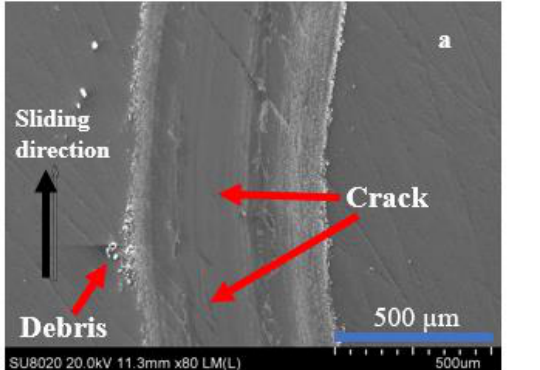
Figure 8. Evolution of friction coefficient of the as-deposited and heat-treated samples determined during a 1000 m of ball-on-disk sliding test.